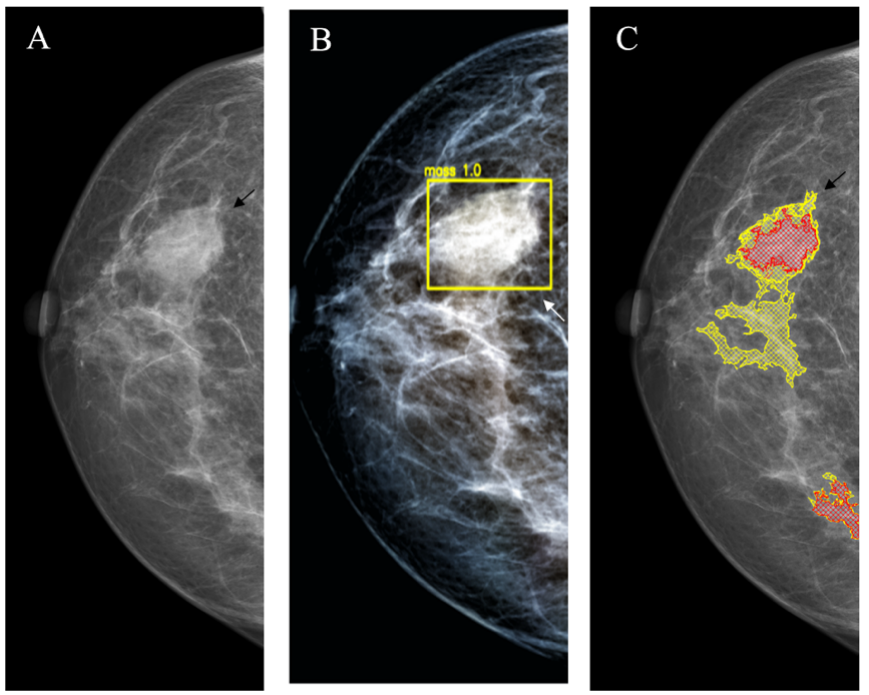
Figure 6. Round- or oval-shaped mass with clear border (arrow). ( A ): Source image; ( B ): YOLOv4 Figure 6. Round ‐ or oval ‐ shaped mass with clear border (arrow). ( A ): Source image; ( B ): YOLOv4